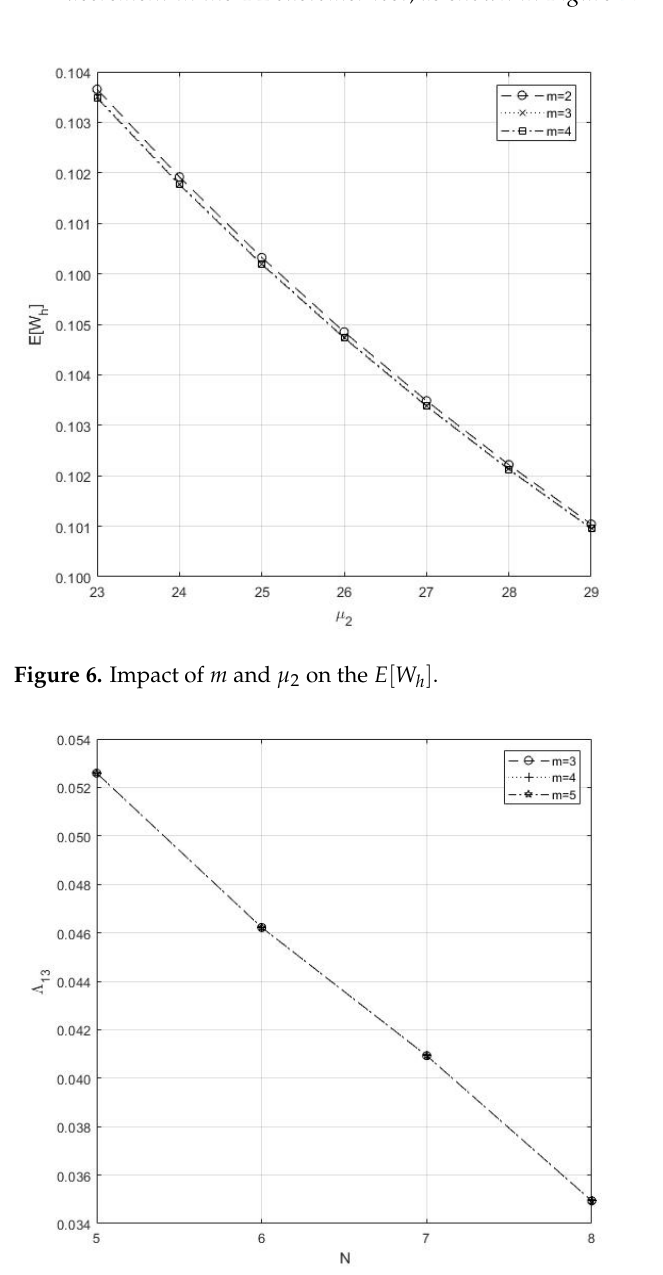
Figure 7. Mean number of Type-II customer lost for m vs. N